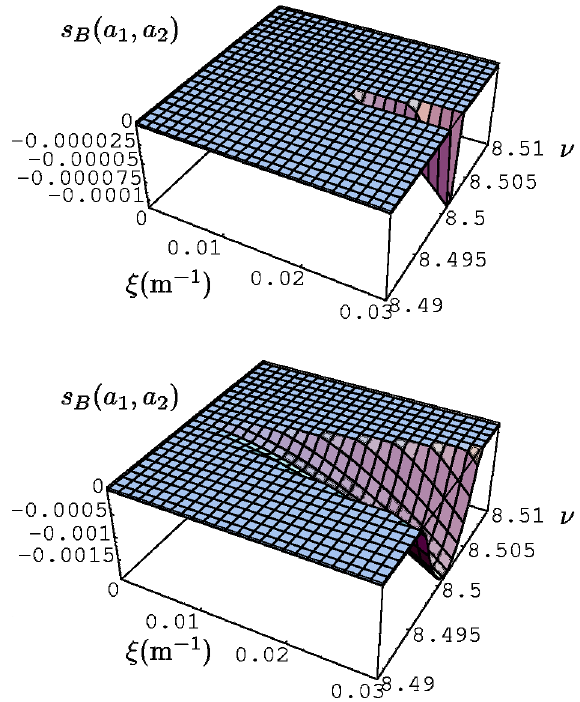
stop band is not only much s